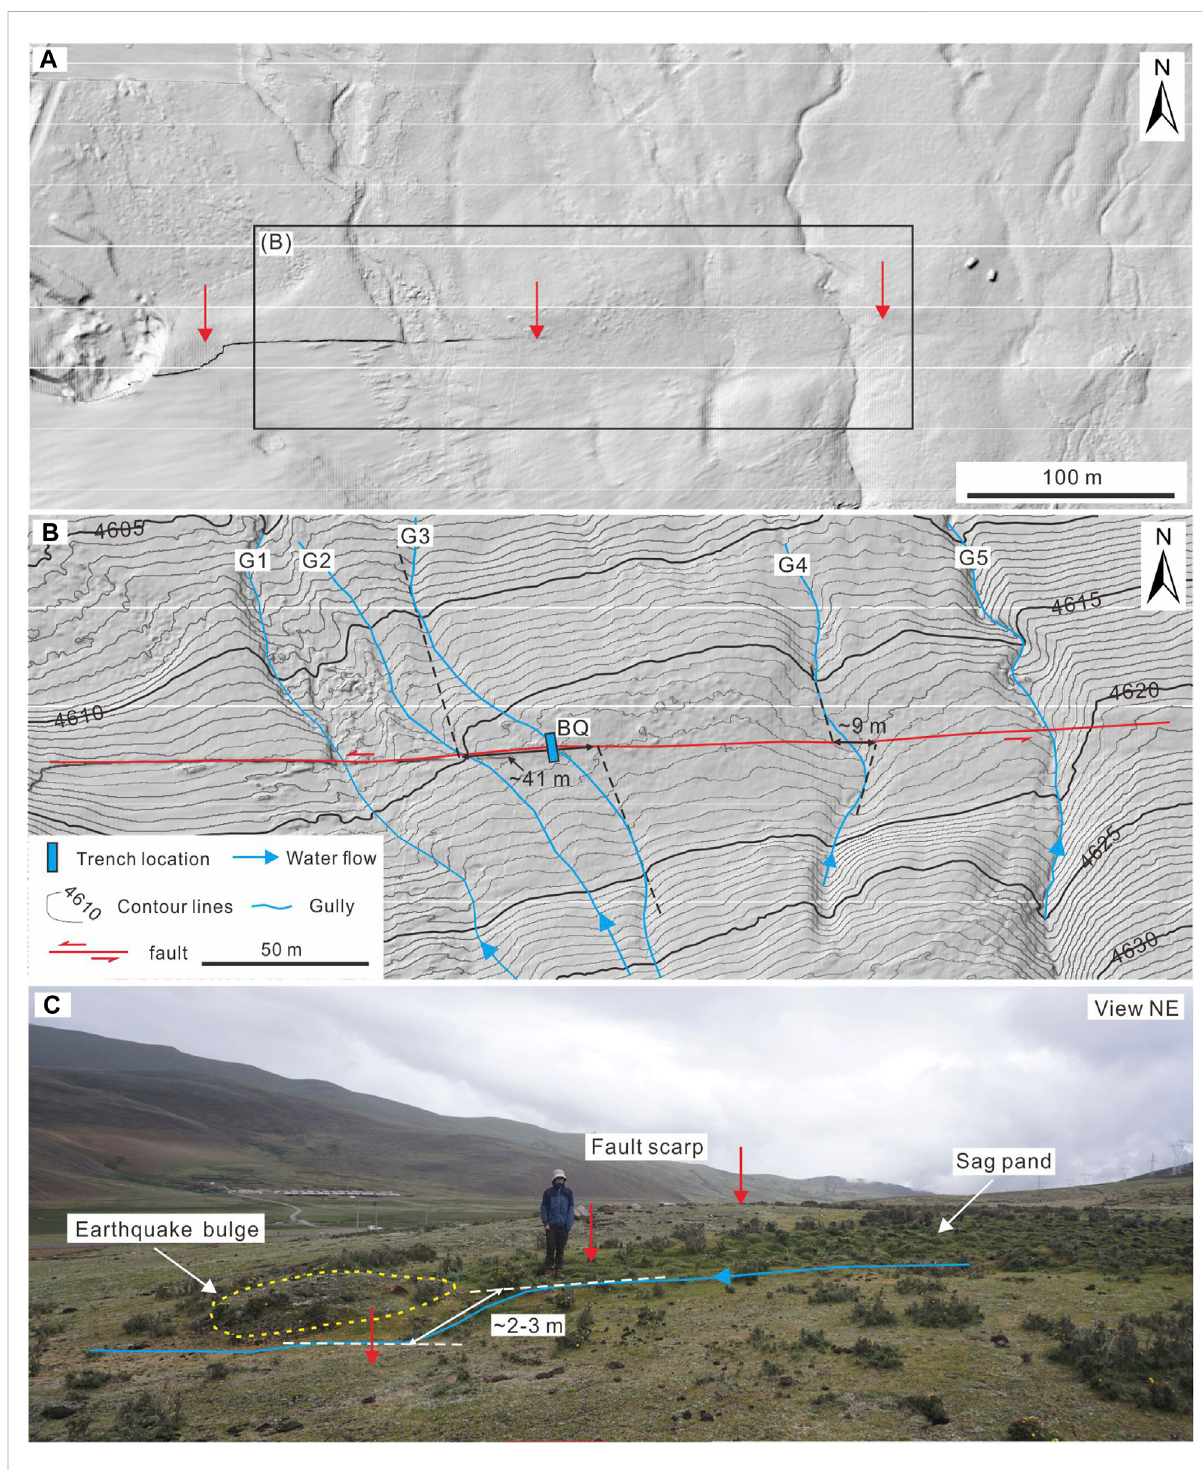
FIGURE 10 Faulted landforms around the trench BQ excavation site. (A) The hillshade map is generated from an unmanned aerial vehicle-based digital elevation model. The location is shown in Figure 2. The red arrows point to the surface trace of the fault. (B) Interpretation map of the offset landforms in (A) . The contour interval is 0.5 m. (C) Field photo of the faulted landforms around trench